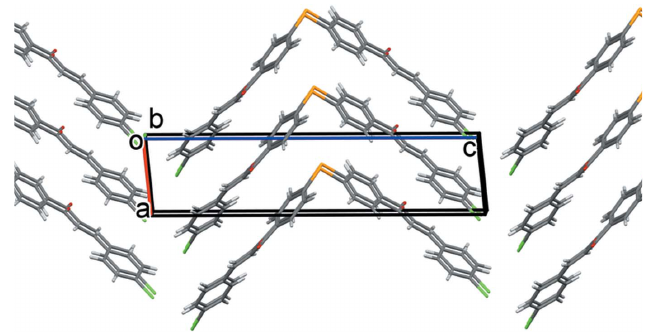
Figure 2 A view along the b axis of the crystal packing of the title compound, showing the layer-like structure.